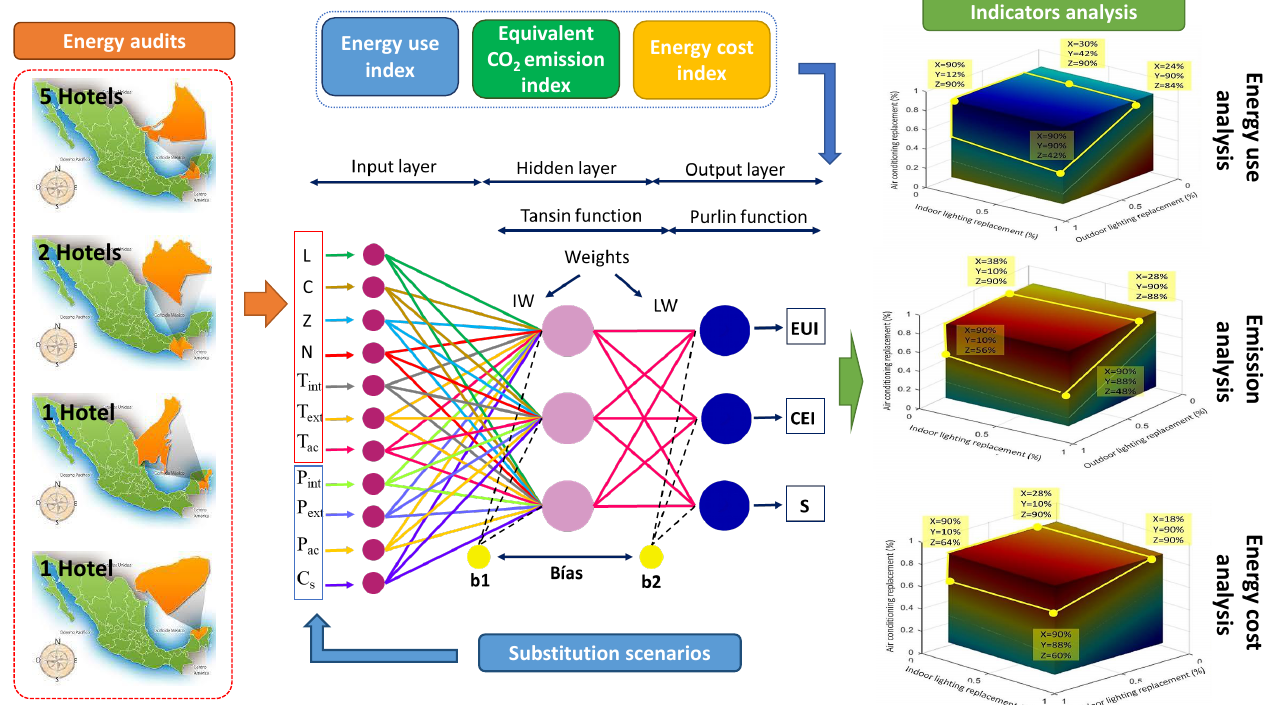
Figure 2. Simplified description of the methodology for the analysis of energy, environmental, and economic indicators aided by artificial